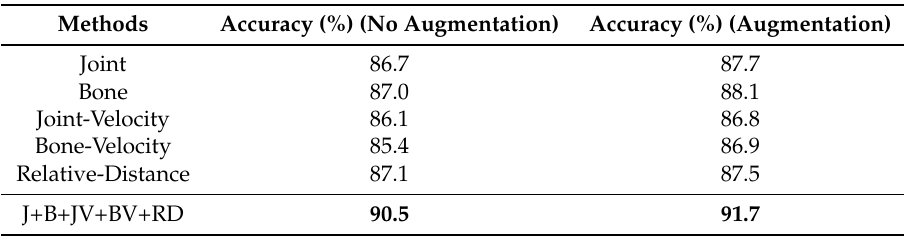
Table 1. Comparisons of the validation accuracy with different input modalities on a cross-subject benchmark of the NTU-RGBD dataset.